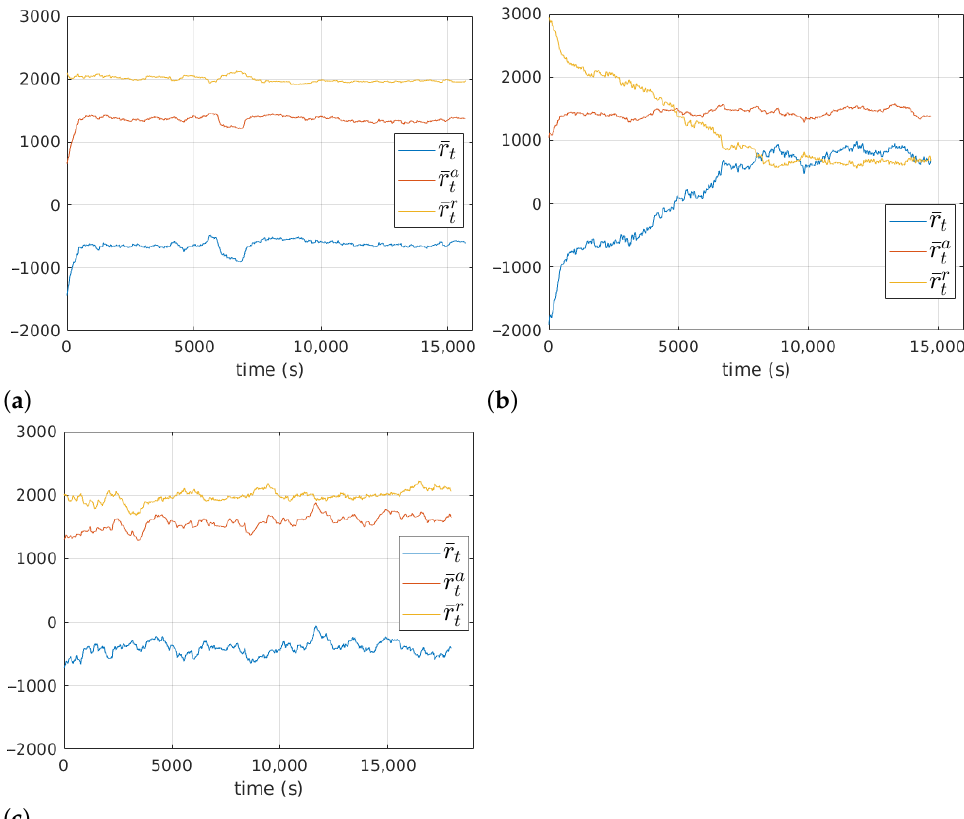
Figure 17. Evolution of the reward function at the first ( a ), the second ( b ) and the third ( c )